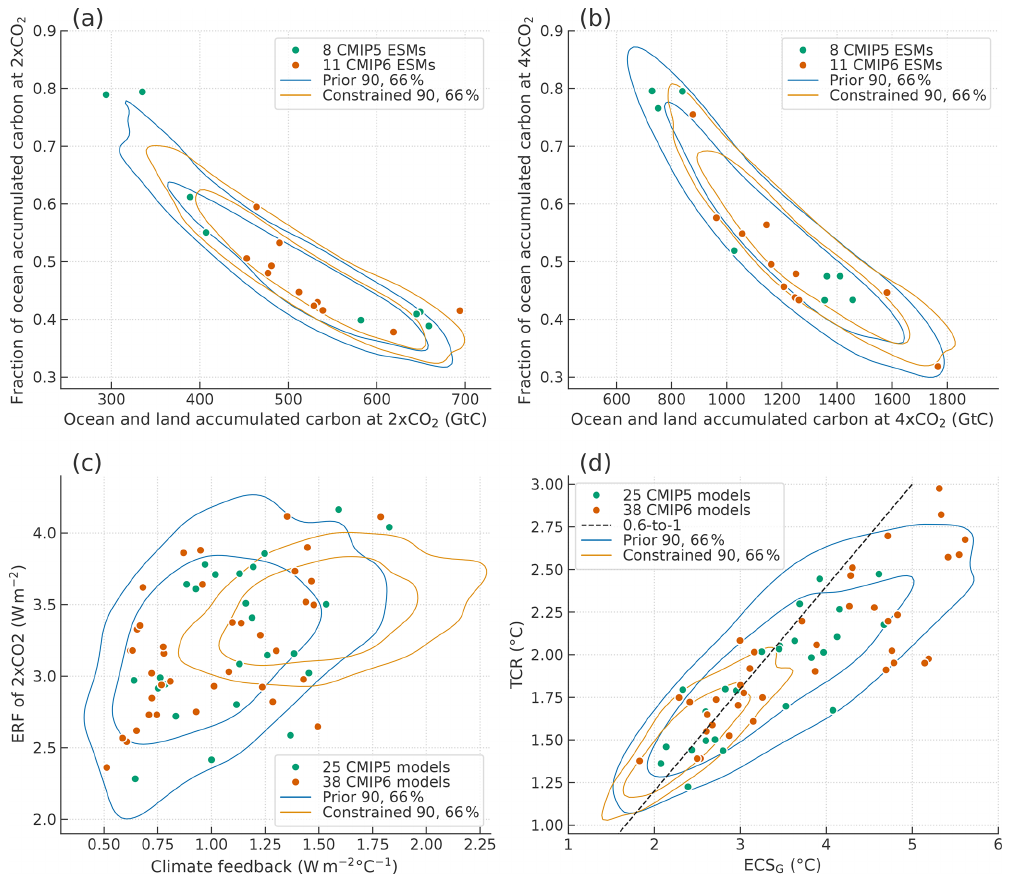
Figure 9. Relationships between key indicators associated with carbon budget and climate sensitivity in comparison with CMIP models. Contours indicate kernel density levels at which the circles cover 90% and 66% of members. The legend indicates the number of the CMIP models. (a) The fraction of ocean accumulated carbon as well as ocean and land totals in the 70th year of 1pctCO2. (b) Same as panel (a) , but in the 140th year. (c) Effective radiative forcing (ERF) of CO 2 doubling and climate feedback parameter. (d) Transient climate response (TCR) and equilibrium climate sensitivity diagnosed from abrupt-4xCO2 (ECS G ). The dashed line is located where the ratio of TCR to ECS G is 0.6 as a